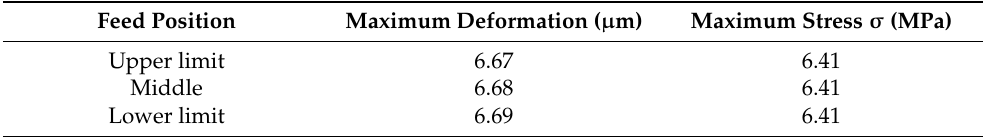
Figure 9. Equivalent load distribution on the connecting surface of the bearing housing. ( a ) Integral structure ( b ) Separate structure. Table 1. Static deformation and stress of integral structure.